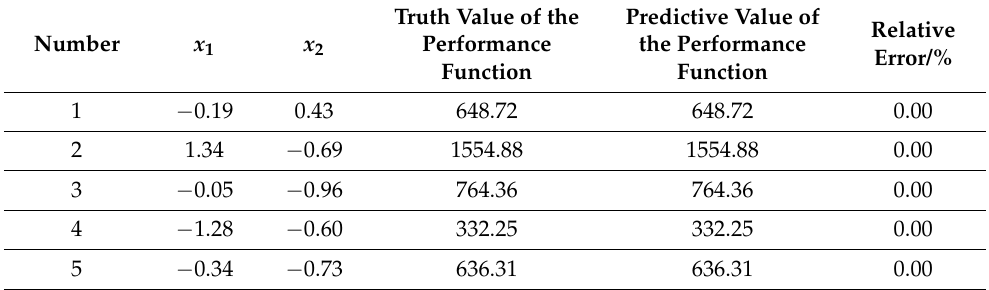
Table 2. The initial training samples and function values of Case 1.